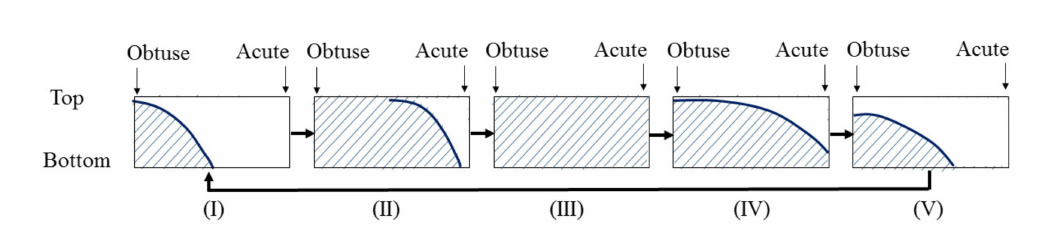
Figure 12. Development of soil pressure behind abutment.